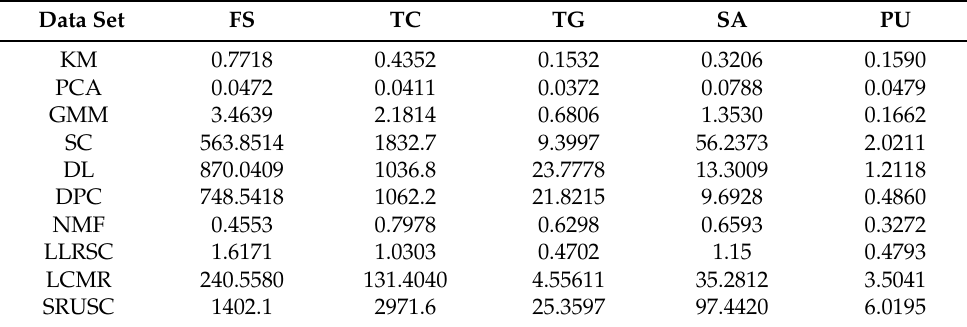
Table 2. Running time for different methods measured in seconds. The methods that require the computation of eigenvectors of a graph (SC, DL, SRUSC) are slower than methods that do not. However, all methods require only at most minutes to run, even on the largest